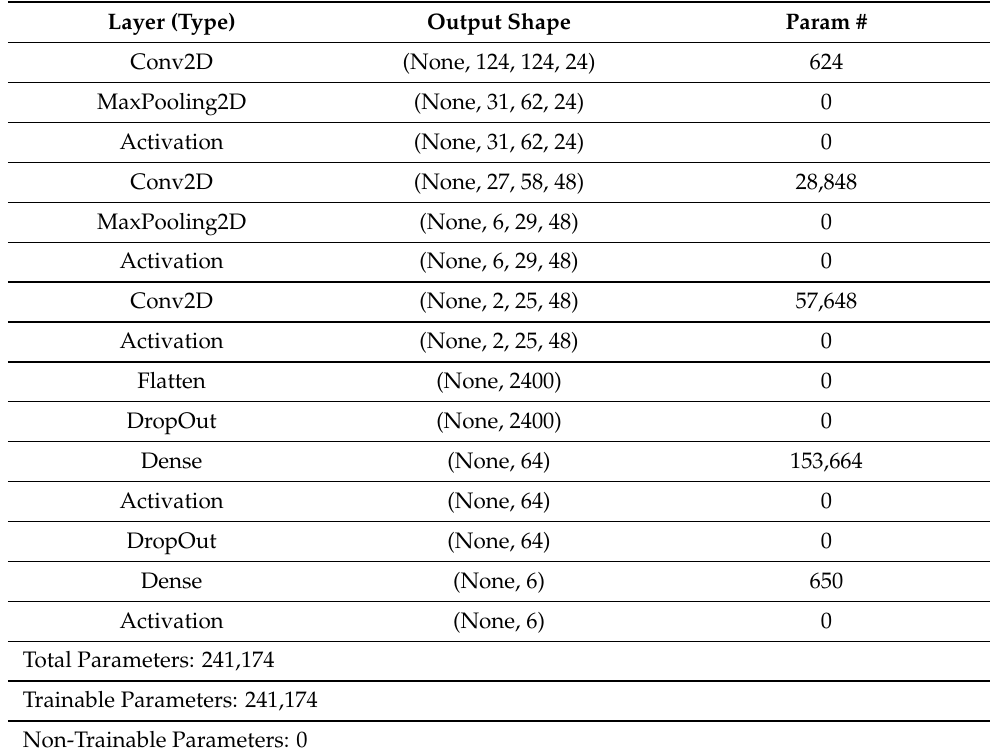
Table 2. FDC-1 Model